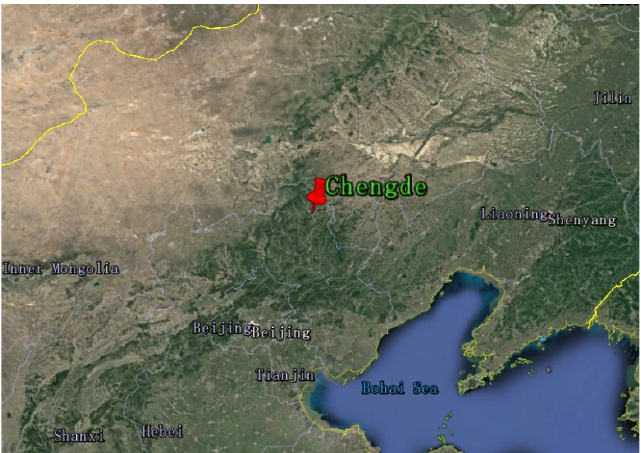
Figure 2. Location of the meteorological station of Chengde (from Google Earth).